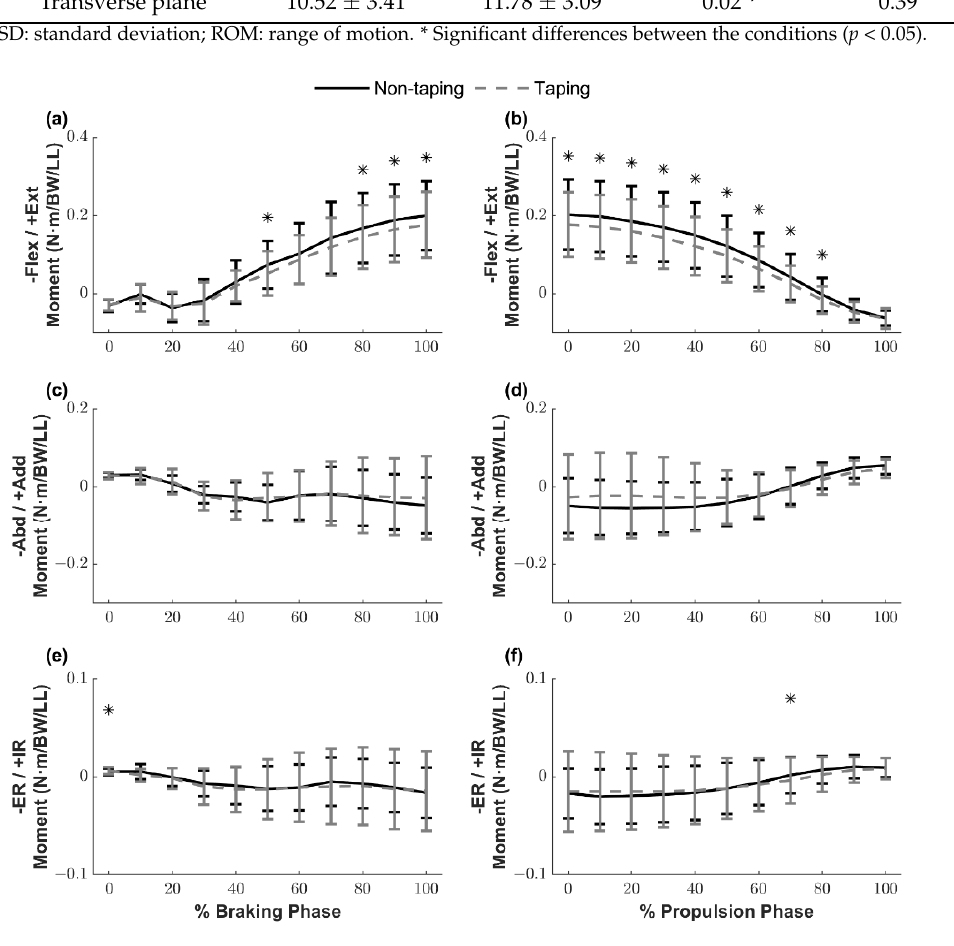
Figure 6. Knee joint moment ensemble curves during the braking and propulsion phases, shown for 10% increments. ( a ) Knee flexion/extension joint moment in the braking phase; ( b ) knee flex- ion/extension joint moment in the propulsion phase; ( c ) knee abduction/adduction joint moment in the braking phase; ( d ) knee abduction/adduction joint moment in the propulsion phase; ( e ) knee external rotation/internal rotation joint moment in the braking phase; ( f ) knee external rotation/in- ternal rotation joint moment in the propulsion phase. * Significant differences between the condi- tions. Flex/Ext: flexor/extensor; Abd/Add: abductor/adductor; ER/IR: external rotator/internal rota- tor; BW: body weight; LL: leg